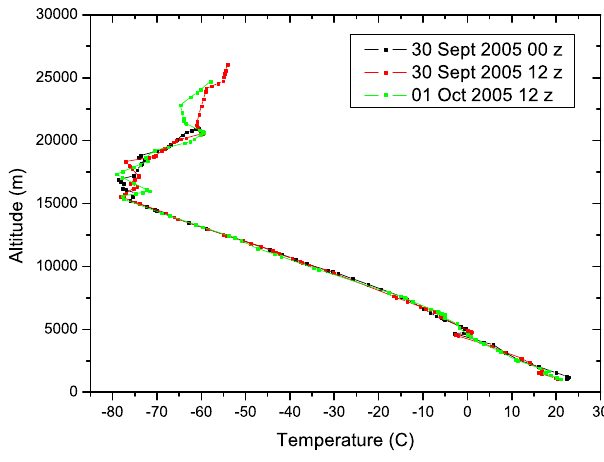
Fig. 4. Temperature profile of the atmosphere at Bras´ılia (15.86 ◦ S, 47.93 ◦ W) showing an average tropopause temperature of − 76 ◦ C.